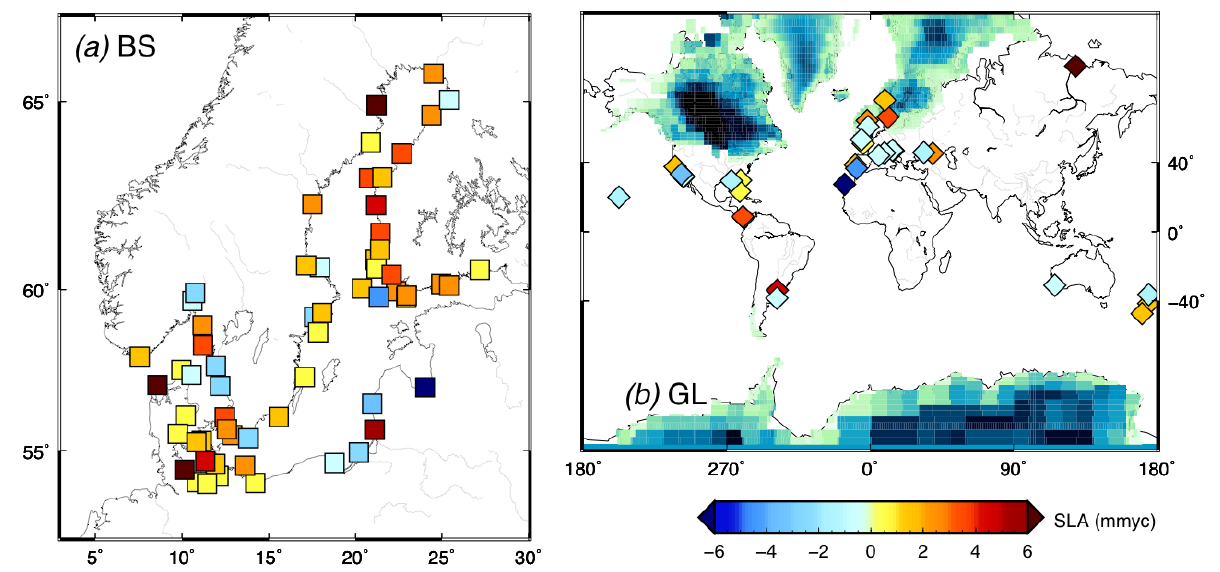
Figure 1. Location of tide gauge instruments. (a) Location of Baltic Sea (BS) tide gauges (number of records: 60, minimum record length: 100 years, average completeness: 92%). In (b) the global (GL) set is considered (32, 56 years, 58%). Shades of blue in (b) depict the thickness of the ice sheets at the Last Glacial Maximum according to the GIA model ICE-5G(VM2) [Peltier 2004]. Colors of squares and diamonds de- note the local sea-level acceleration (1 mmyc = 1 millimeter per year per century). All time series and tide gauge station information are ex- tracted from the PSMSL database of annual RLR (revised local reference) records [Woodworth and Player 2003].